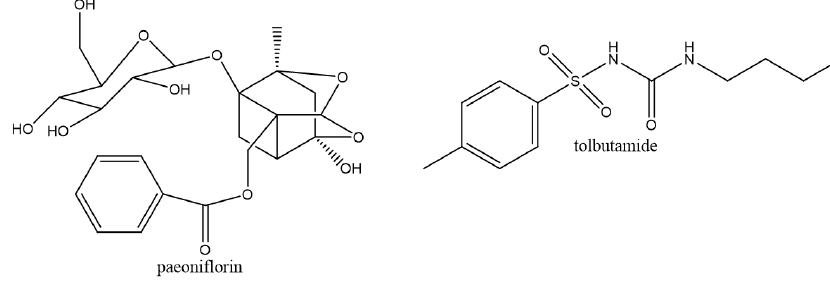
Figure 1. Chemical structures of paeoniflorin and tolbutamide